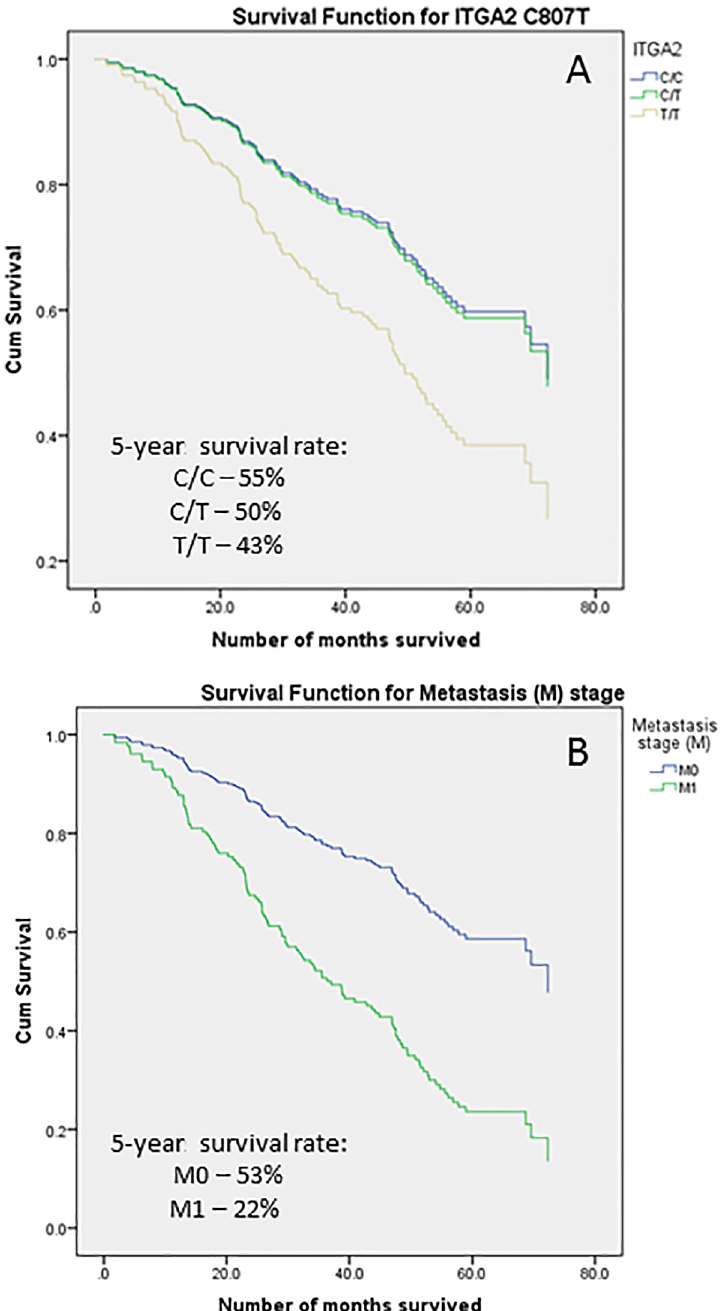
Fig 1. The survival functions for ITGA2 C807T polymorphism (A) and metastasis status (B).